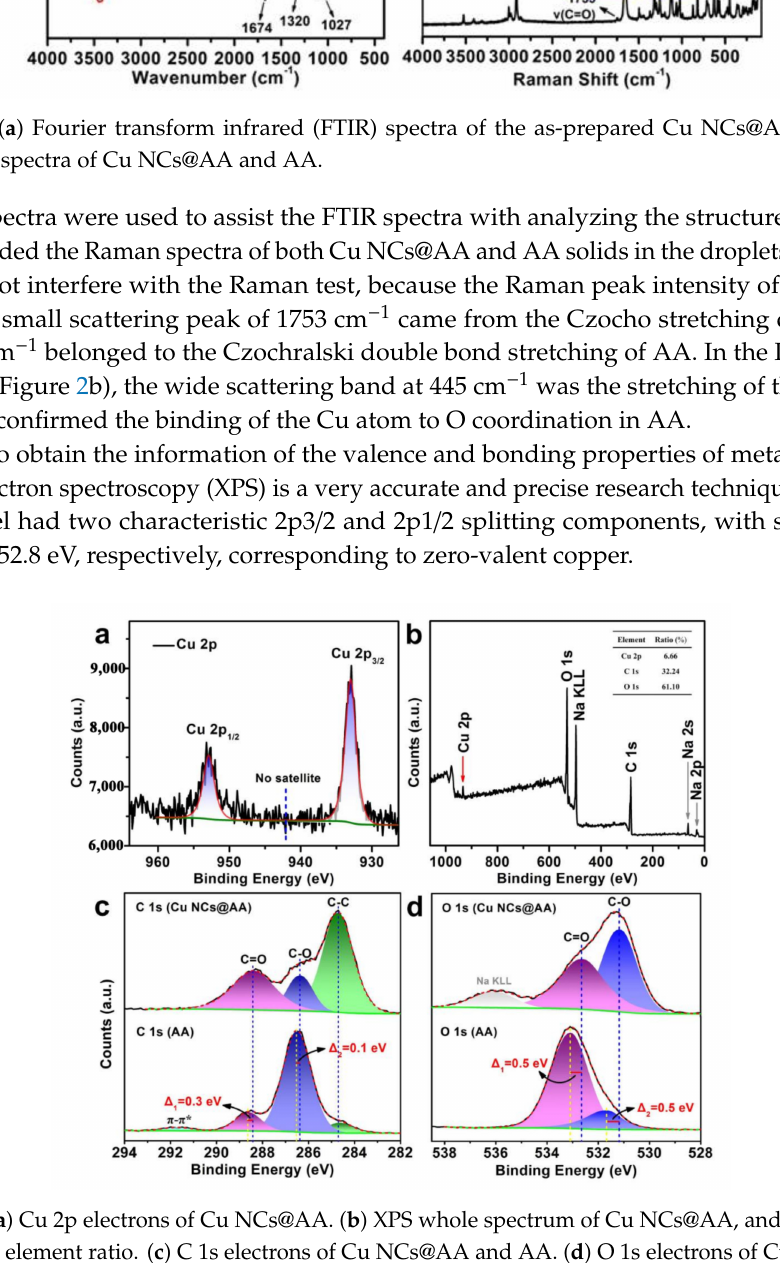
table of the element ratio. ( c ) C 1s electrons of Cu NCs@AA and AA. ( d ) O 1s electrons of Cu NCs@AA and